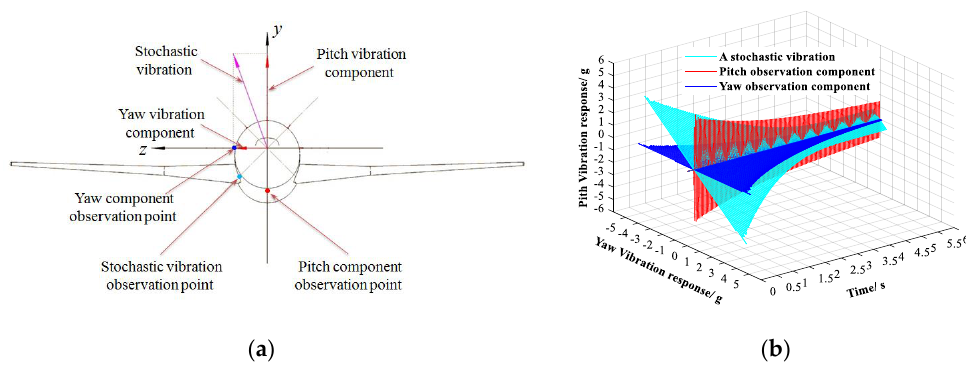
Figure 6. Layout of accelerometers and observation of vibration. ( a ) Layout of accelerometers. ( b ) Observation of stochastic vibration.